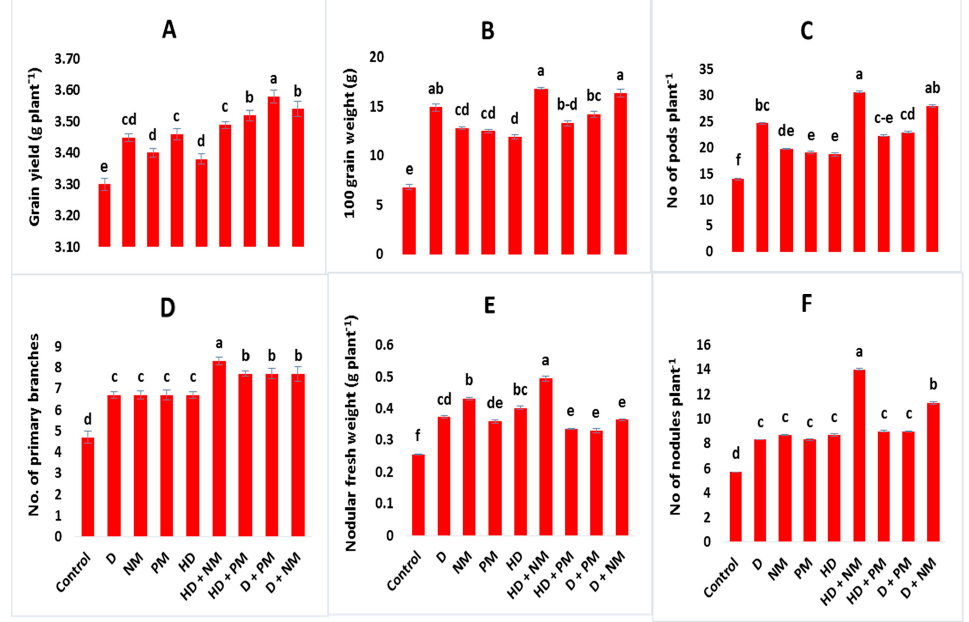
Figure 2. Effect of animal manures with DAP fertilizer on nodulation and yield attributes of chickpea ( A ) grain yield, ( B ) 100 grain weight, ( C ) No. of pods per plant, ( D ) No. of primary branches, ( E ) Nodular fresh weight and ( F ) No. of nodules per plant of chickpea. D: Recommended DAP; NM: Normal manure; PM: Processed manure; HD: Half of the recommended dose of DAP. Figure bars are showing the mean values ( n = 3). All means followed by different letters have statistically significant differences according to Tukey’s HSD test at probability level of